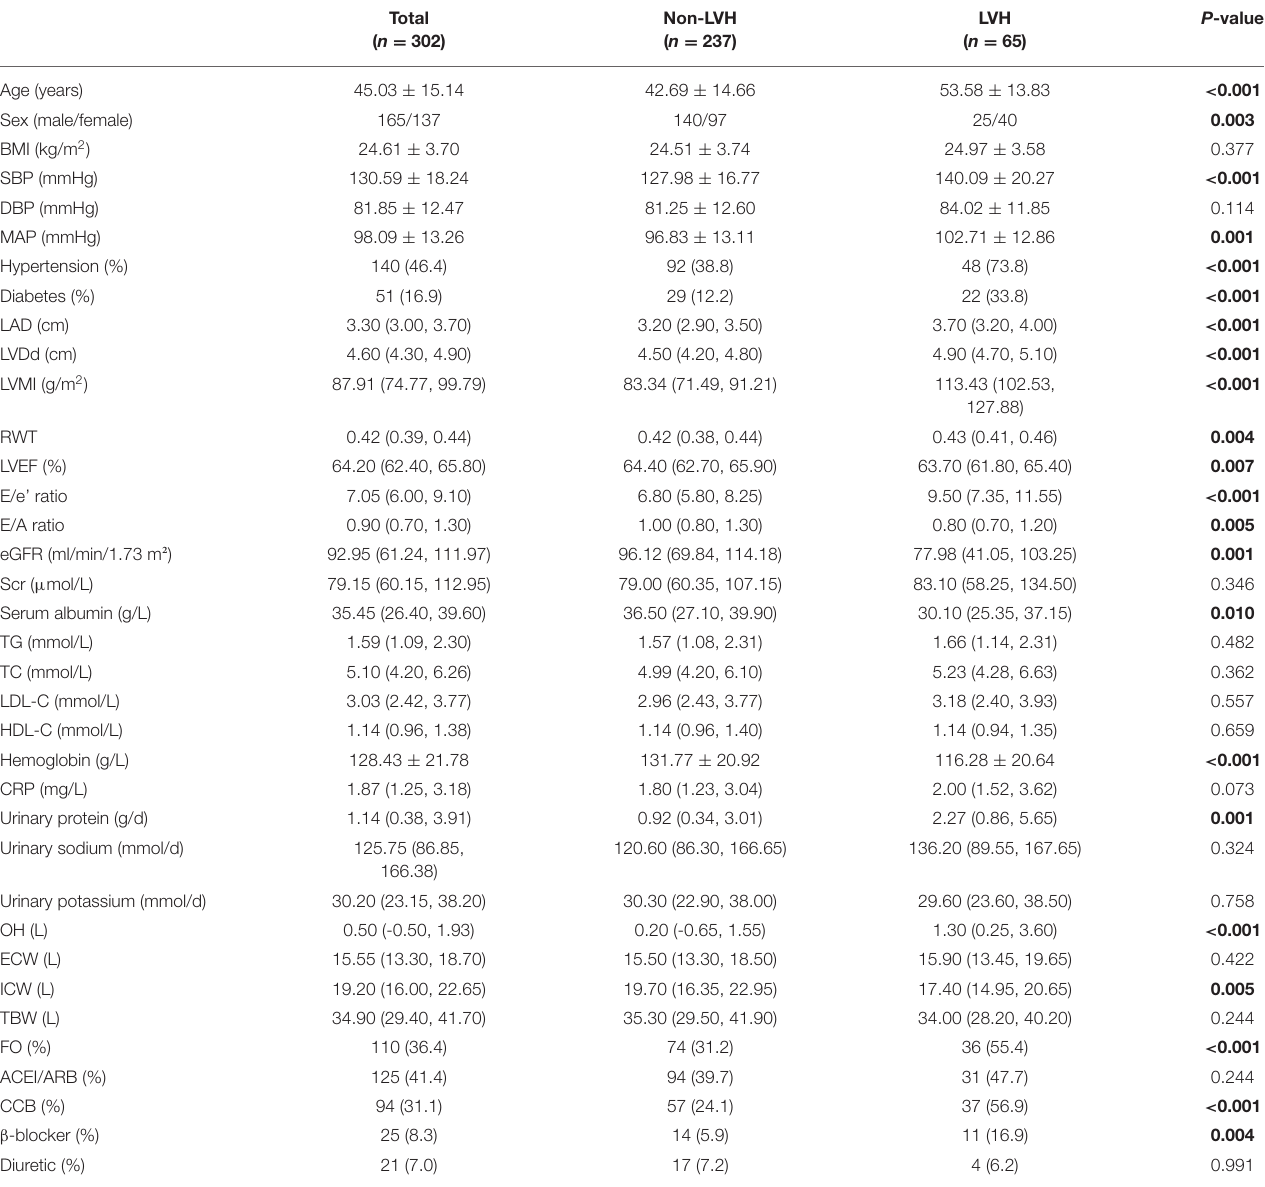
TABLE 1 | Comparisons of clinical, laboratory, and echocardiographic parameters and volume status between the non-LVH and LVH groups in patients with